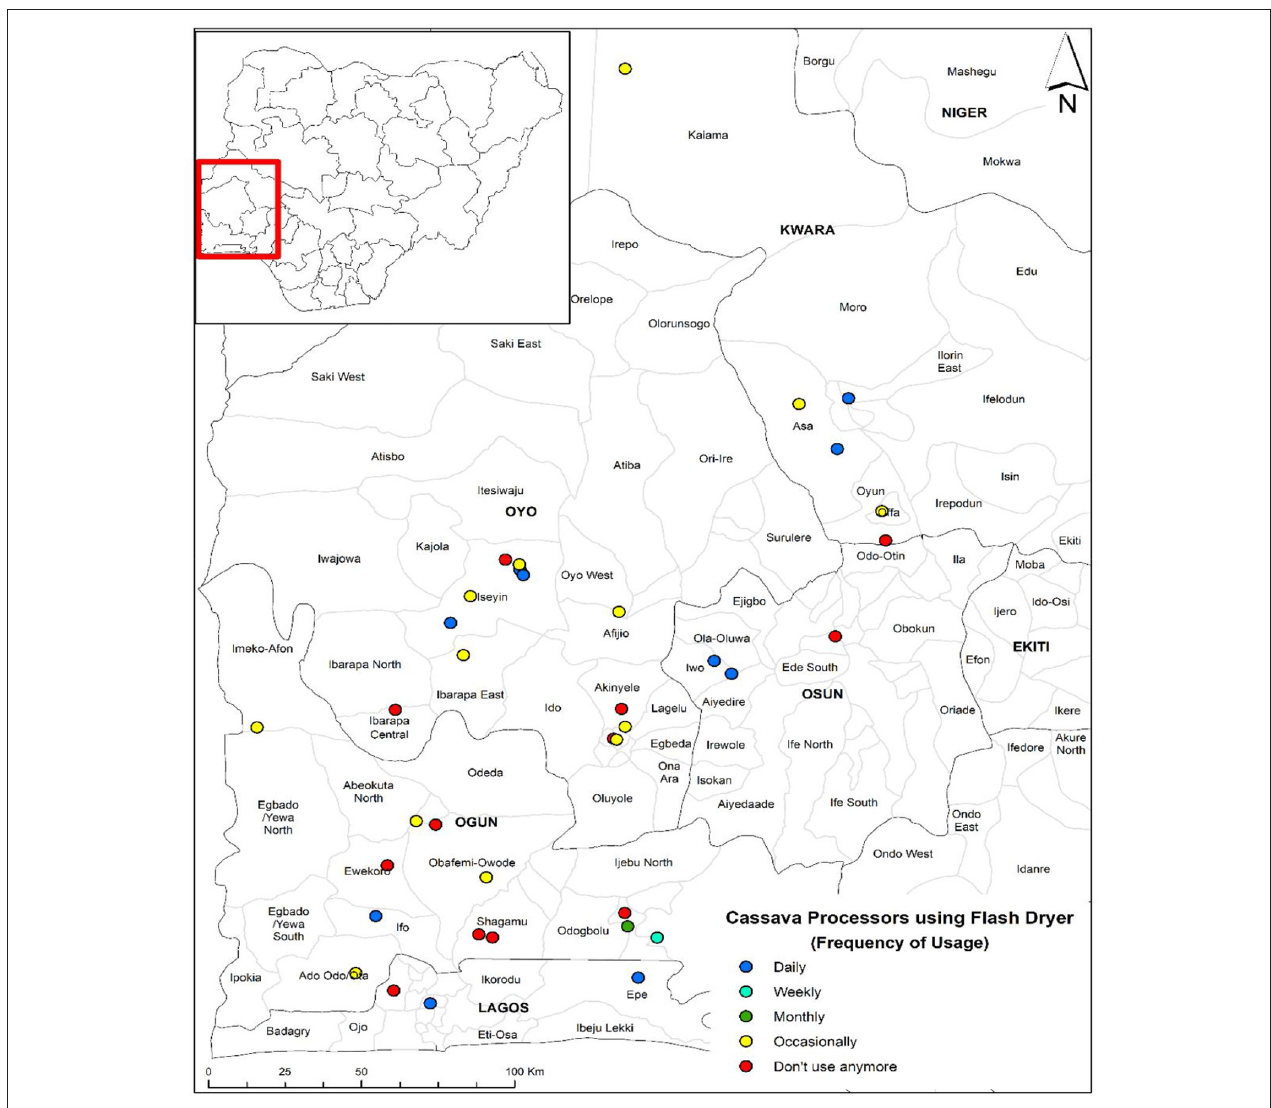
FIGURE 3 | Cassava processors using flash dryers (frequency of